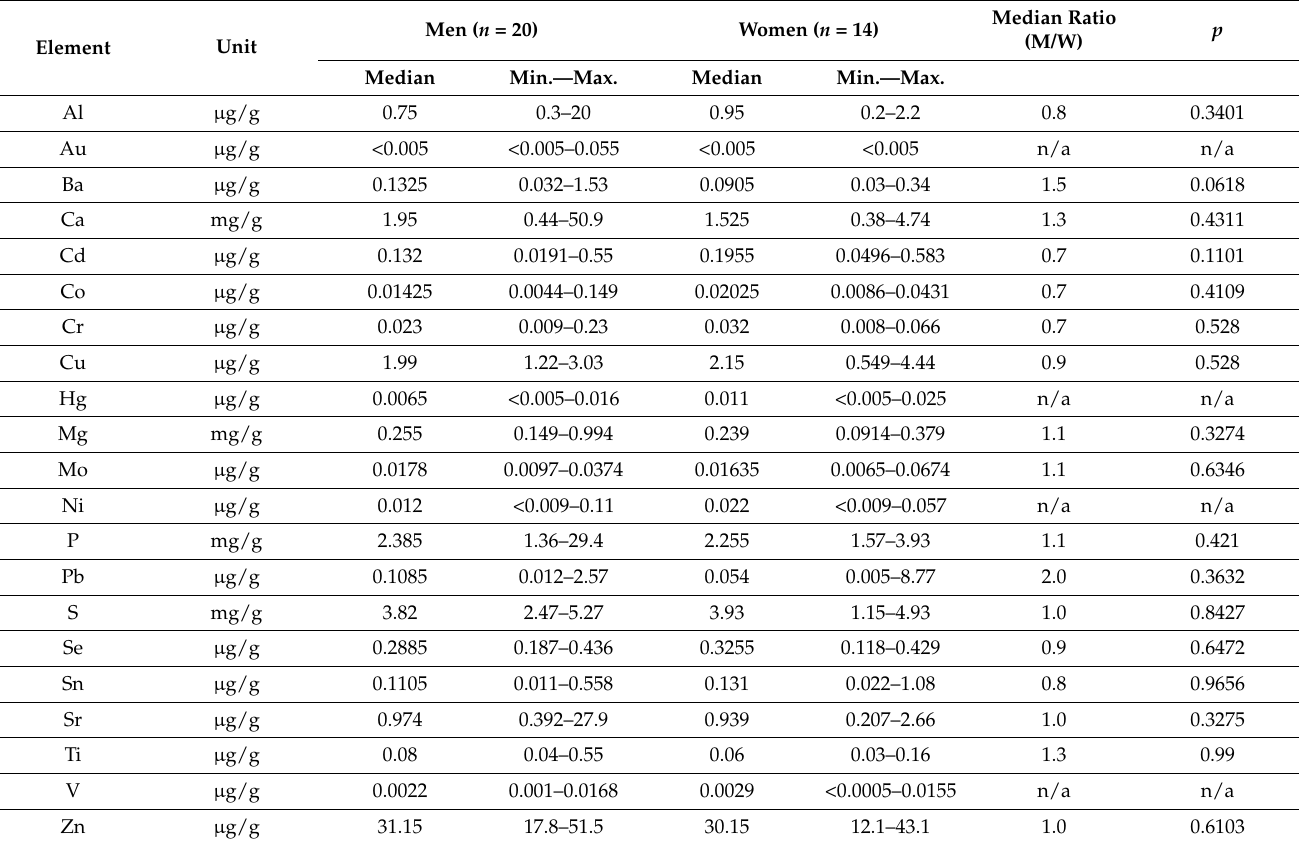
Table 6. Concentrations of metals and trace elements in the tissue of healthy aortic valves— comparison of men and